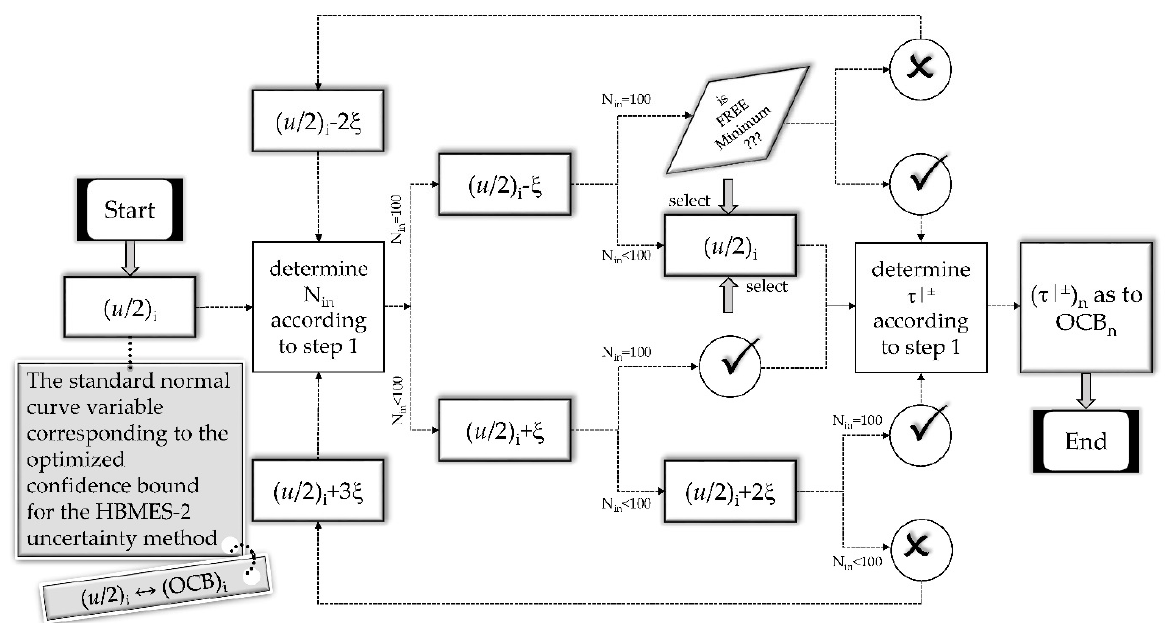
Figure 2. Process of assessment of the OCB n (narrowest confidence bound that covers all measured data) in HBMES-2 uncertainty method.